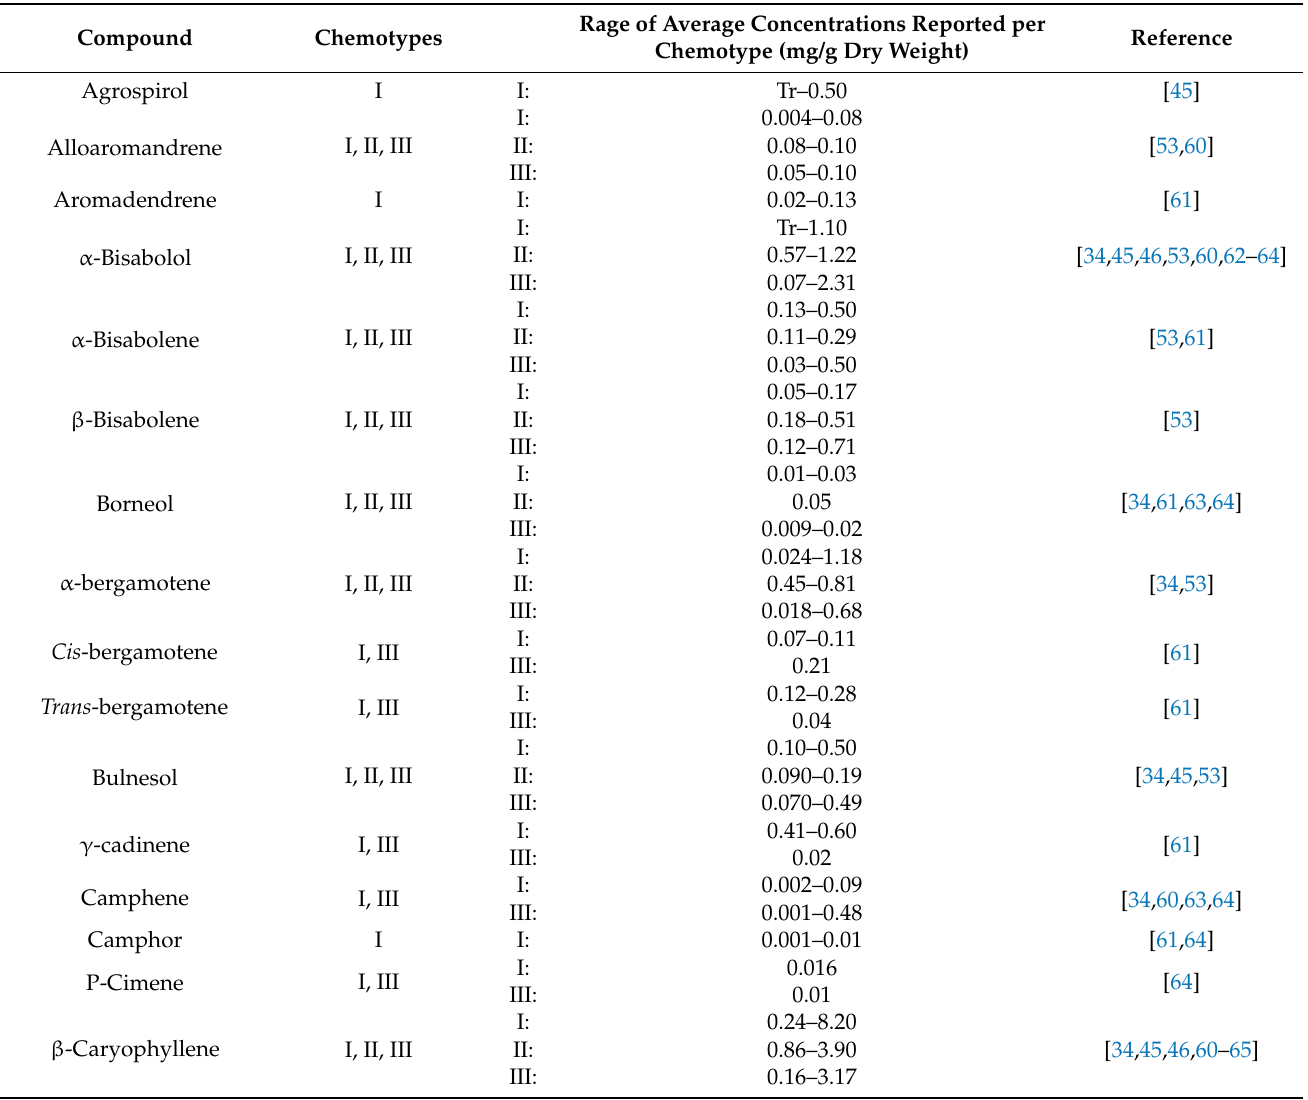
Table 1. Concentrations of terpenes found in cannabis. Concentration range is given by chemotype where available; Tr—trace (<level of